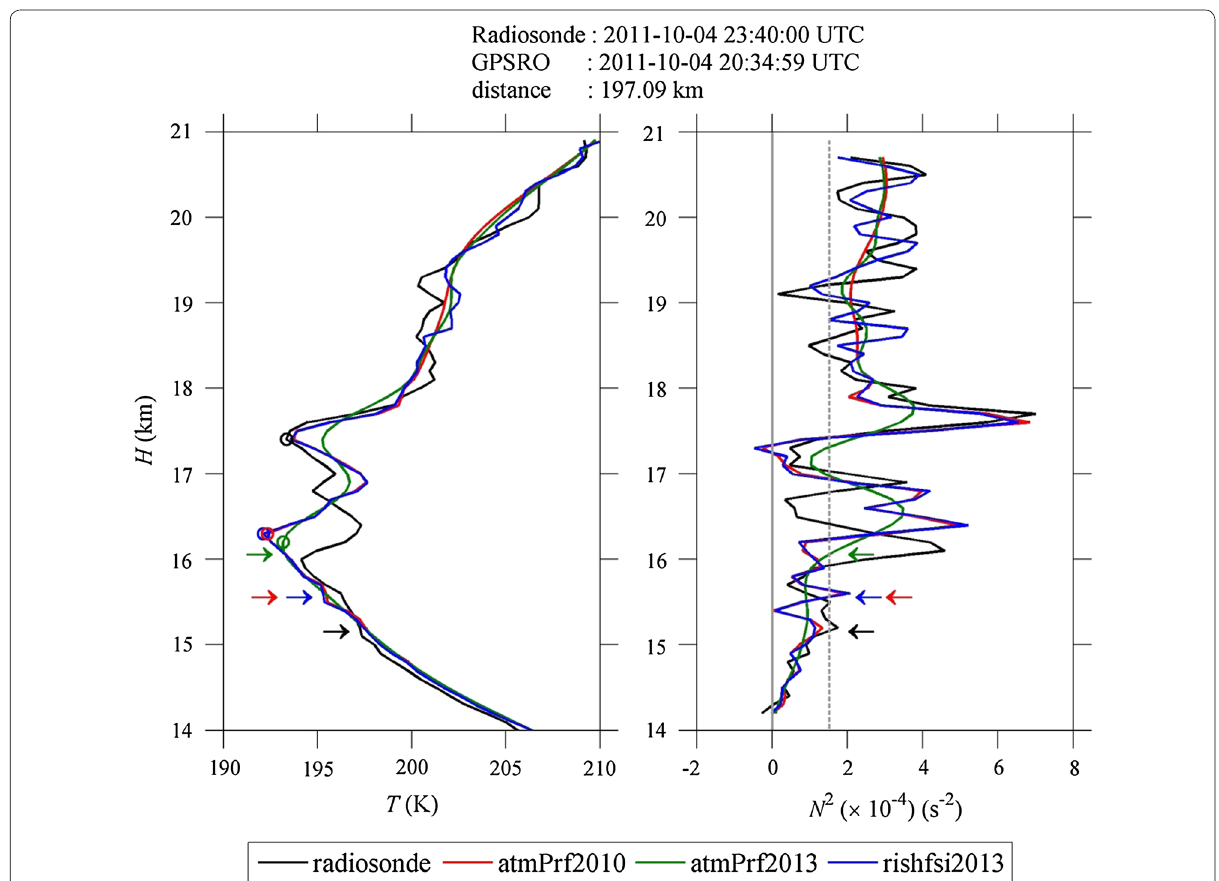
Fig. 11 Comparison of T and Brunt–Väisälä frequency square ( N 2 ) between GPS-RO and a radiosonde on October 4, 2011. CPT and LRT are shown by open circles and arrows in the left panel , respectively. In the right panel , the dotted line shows altitudes of